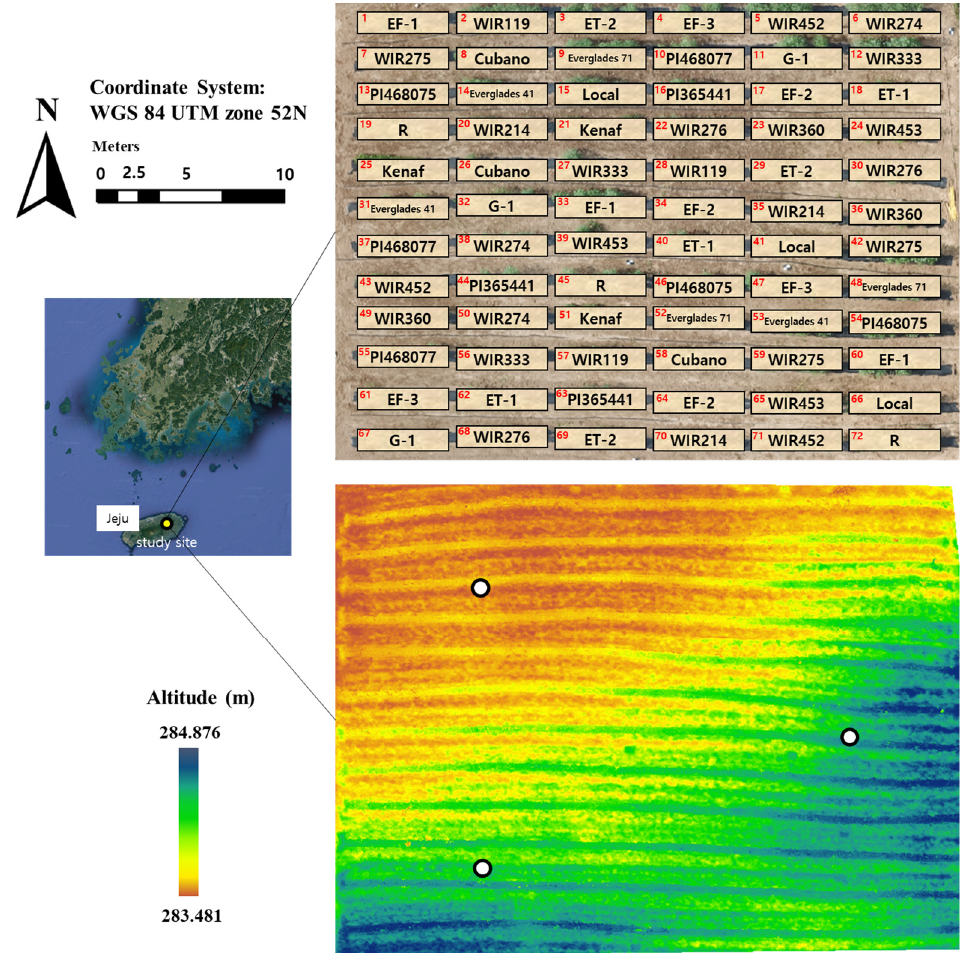
Figure 4. Breeding field used in this study. The upper map shows breeding design, and the letters and the numbers marked in red in each box indicate the varieties of germplasms and plot labels, respectively. The lower map shows the terrain elevation of this field. Three white circles within the field are the soil sampling locations.